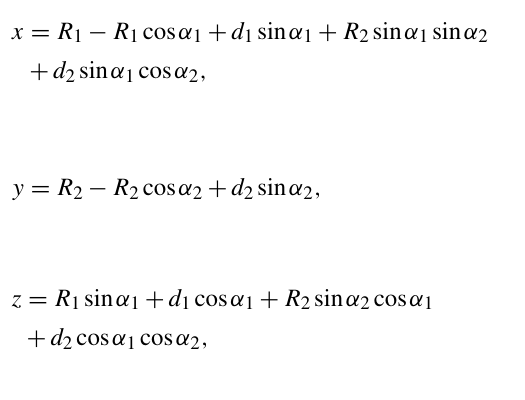
Figure 3. The model of the first bending section. where x , y , and z represent the tip coordinate of the series unit in the task space, and α 1 and α 2 represent the bending angles of the first and second bending sections,